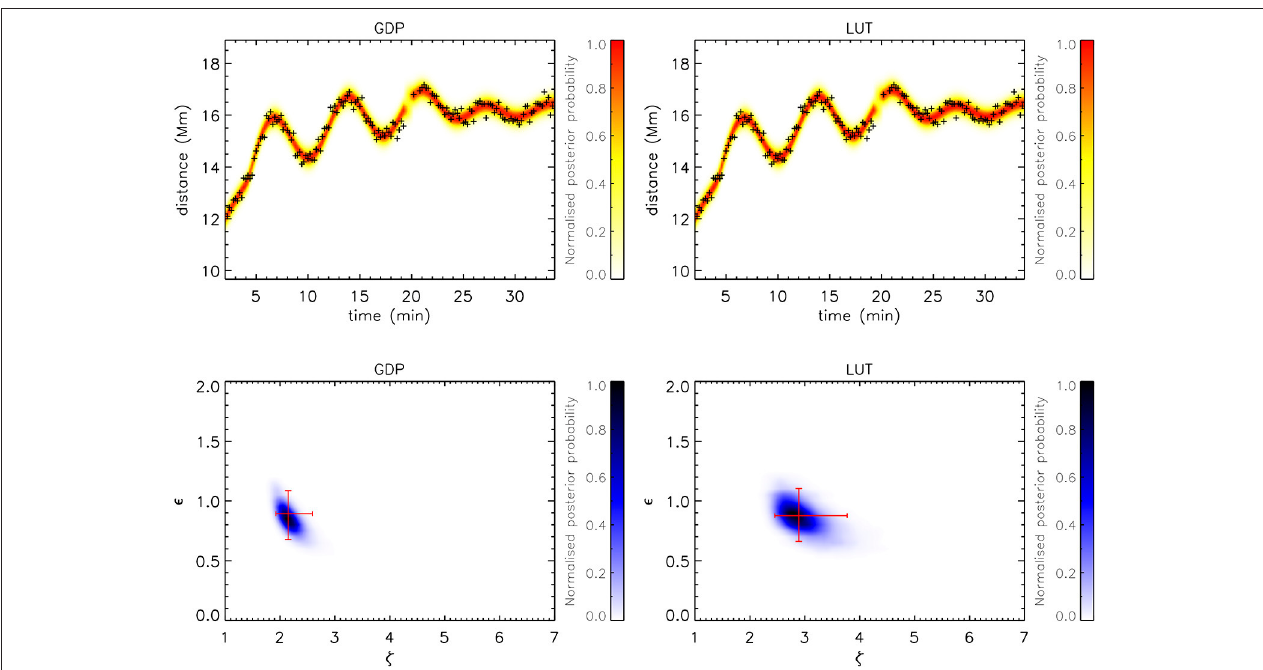
FIGURE 10 | Analysis of the oscillation reported in Pascoe et al. (2018) using the GDP and LUT damping profile. The top panels show the position of Leg 1 (plus symbols) with the color contour representing the normalized posterior predictive probability density for each damping model. Bottom panels as in Figure 8